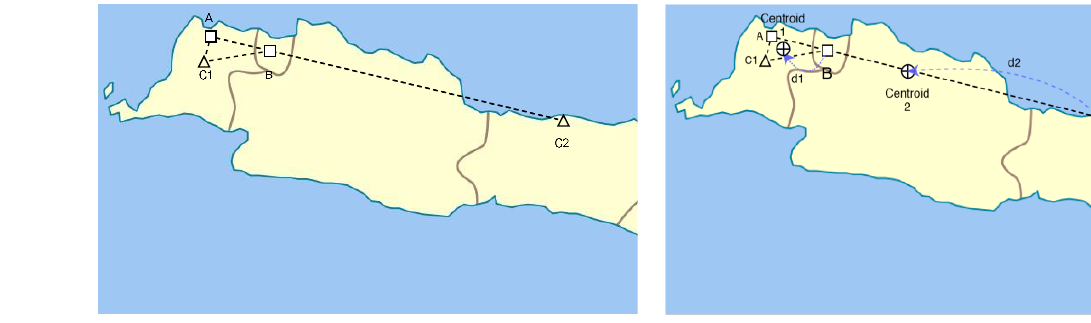
Figure 9. Illustration of difference of strategies between original Spatial Minimality ( a ) and Spatial Minimality Centroid Distance (SMCD) on the ( b ). The SMCD-ADM is SMCD but with adjustment on the weight factor of the distance. Algorithm 3. Algorithm for finding Smallest Administrative Level feature using Spatial Minimality (SM) from [12].